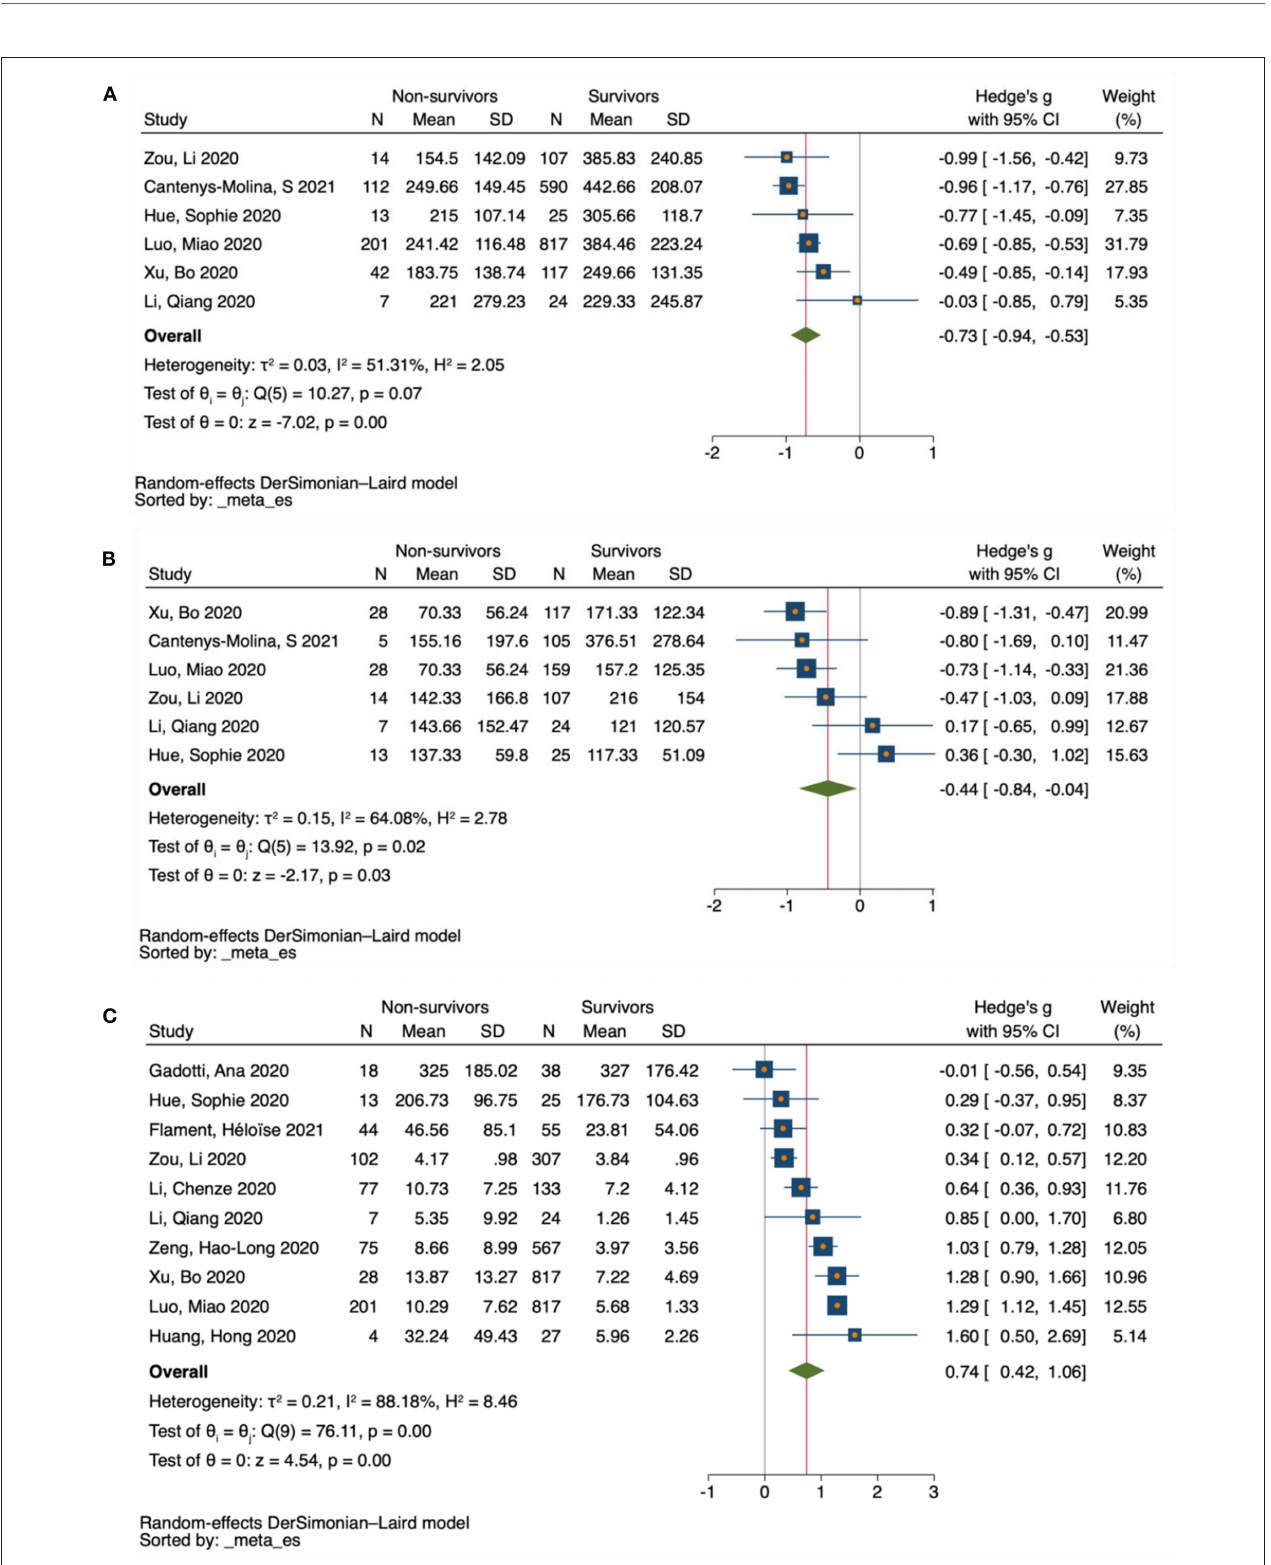
FIGURE 5 | Forest plot of T-cell subsets and IL-10 in COVID-19 mortality studies. (A) CD4 T-cells in COVID-19 mortality studies. (B) CD8 T-cells in COVID-19 mortality studies. (C) IL-10 in COVID-19 mortality studies. The no-effect line is represented at the value of zero. The diamond symbol represents estimated combined effect size.